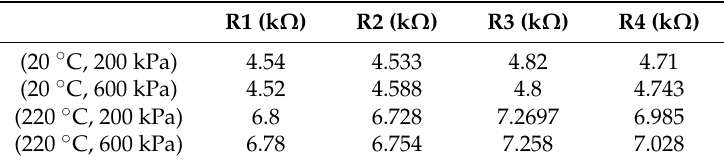
Table 2. Test results for bridge arm resistors under different environmental